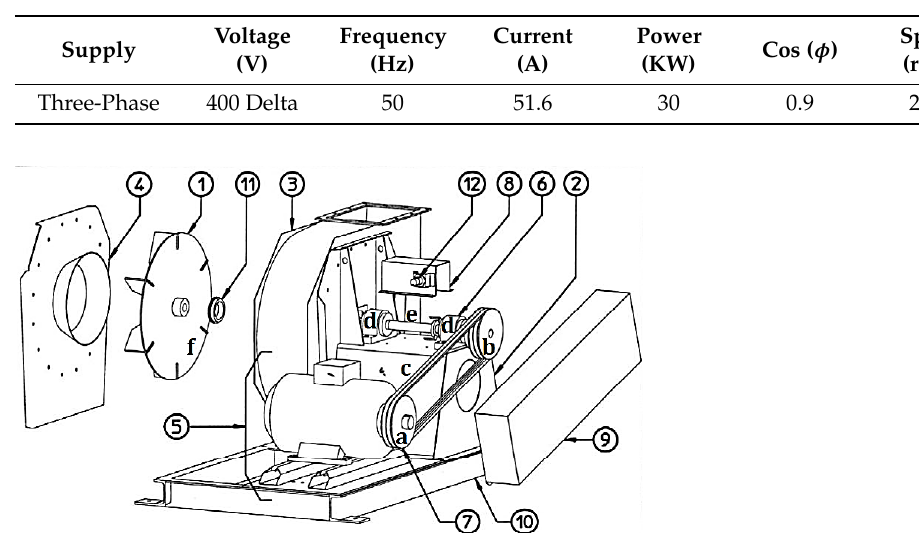
Figure 2. The fan/motor system ( a ) fan side ( b ) transmission side. Table 2. The motor characteristics.